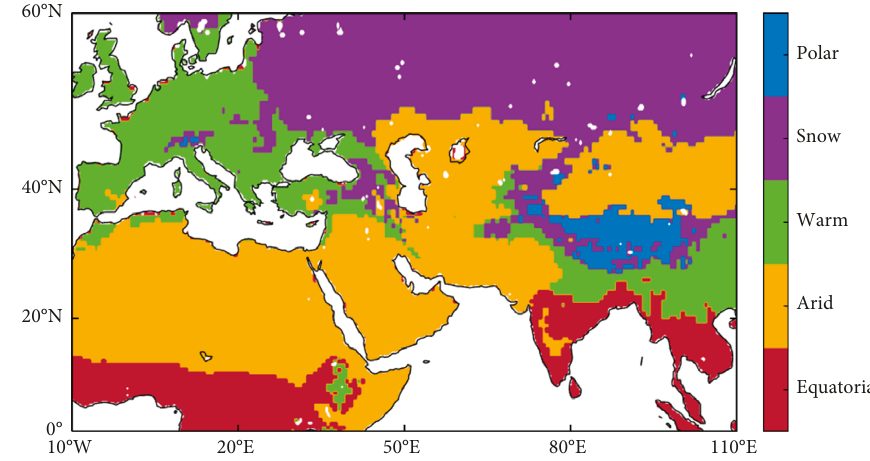
Figure 1: Research area and climate